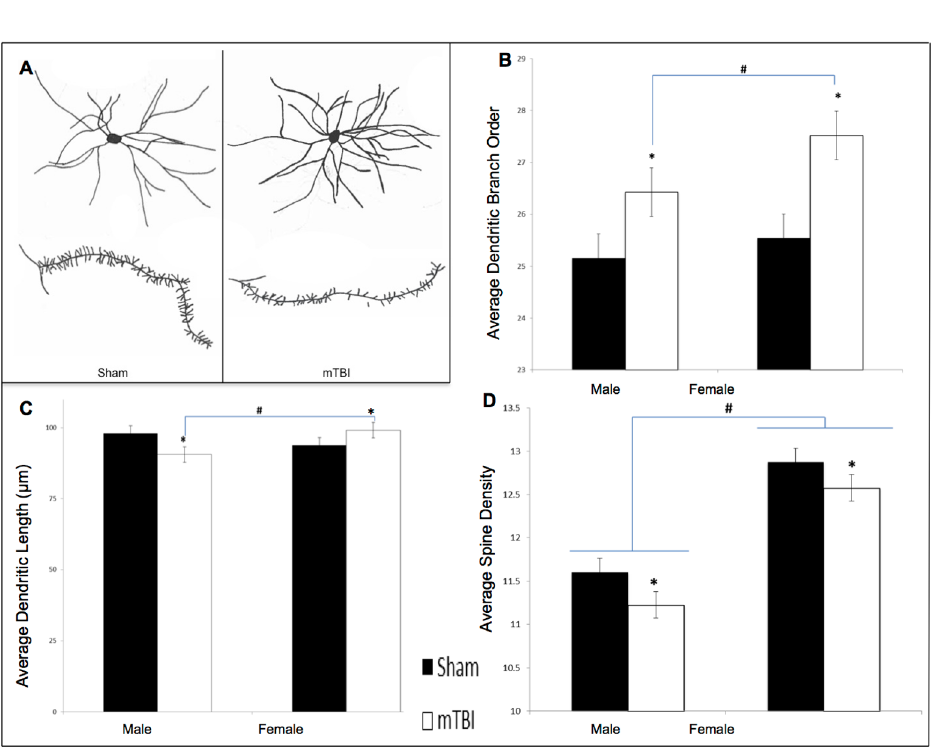
Fig 3. Neuroanatomical findings from STD animals for the NAc medium spiny neurons. A) exhibits a representative tracing of average medium spiny neurons and dendritic spines from the NAc in sham and mTBI animals; B) graphical representation of dendritic branch order from Golgi-Cox stained neurons; C) representation of average dendritic length, and D) is illustrative analysis of dendritic spine density; ( * main effect of mTBI p < .05; # main effect of sex p <